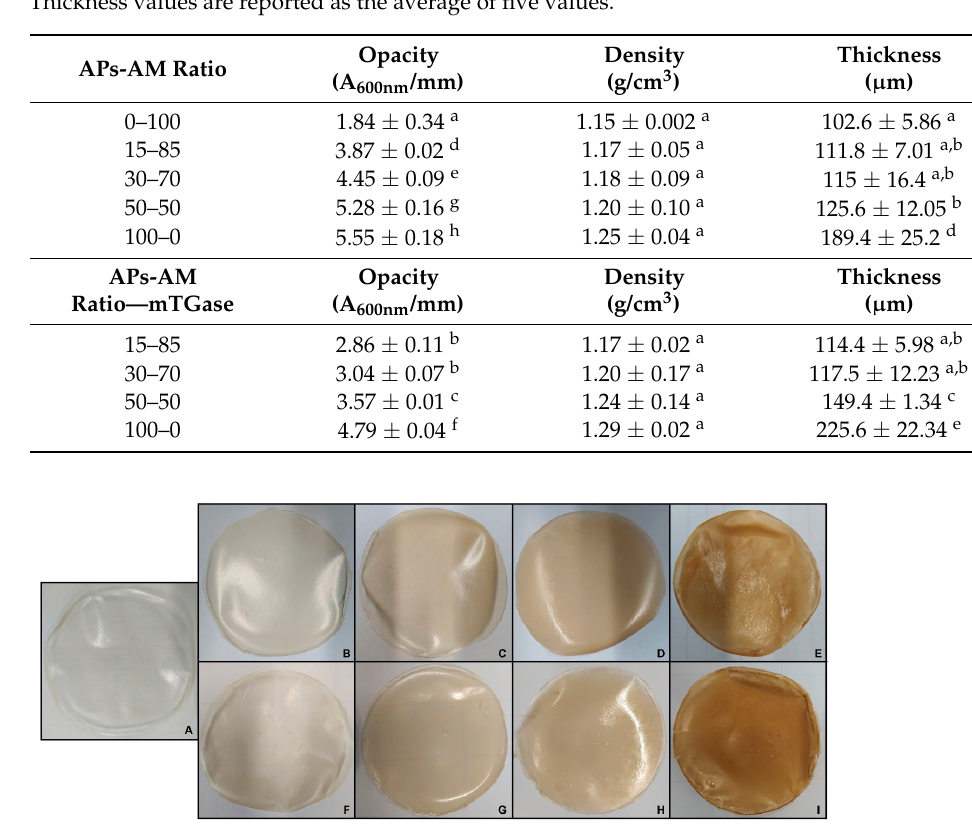
Table 2. Opacity, density, and thickness of films prepared at different ratios APs-AM treated or not with mTGase (40 U/g). Different small letters (a–h) indicate significant differences among the values reported in the columns ( p < 0.05). Analyses of opacity and density were carried out in triplicate. Thickness values are reported as the average of five values.